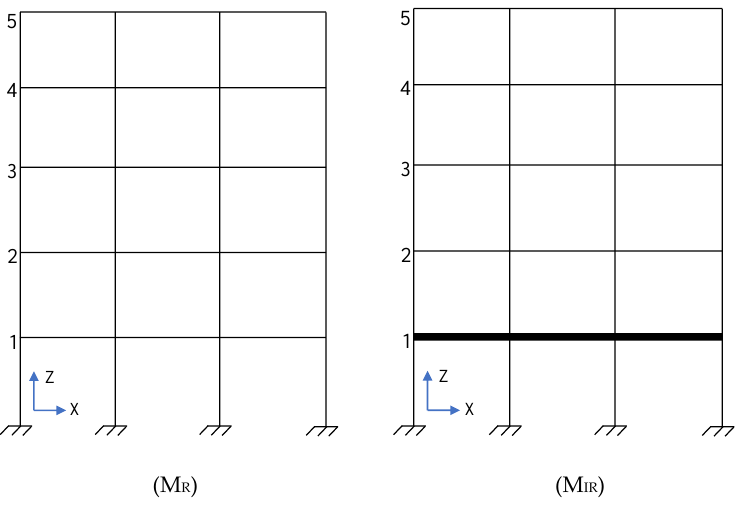
Figure 1. Elevation of five-story regular and irregular building models.